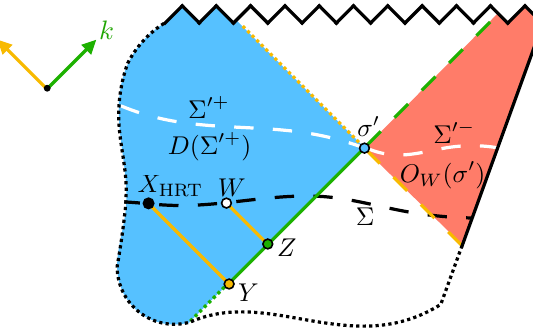
Figure 7 . Illustration of various de(cid:12)nitions appearing in the procedure for maximizing the area of the HRT surface while keeping the outer wedge O W ( (cid:27) 0 ) (red shading) of (cid:27) 0 (blue dot) held (cid:12)xed. The HRT surface X HRT (black dot) must appear in the closure of the inner domain of dependence D ((cid:6) 0 + ) (blue shading) of a Cauchy surface (cid:6) 0 passing through (cid:27) 0 (white dashed line), so the surface Y = N l ( X HRT ) \ N k ( (cid:27) 0 ) exists, on which (cid:18) l (cid:21) 0. By continuity, there must exist (cid:0) (cid:0) a surface Z N + k ( Y ) N k ( (cid:27) 0 ) on which (cid:18) l = 0. By de(cid:12)nition, there exists a Cauchy surface (cid:26) \ (cid:0) (cid:6) X HRT for which X HRT has the minimal cross-sectional area. Since A [ Z ] (cid:27) W = N l ( Z ) (cid:6), it follows that A [ Z ] A [ X HRT \ (cid:21)